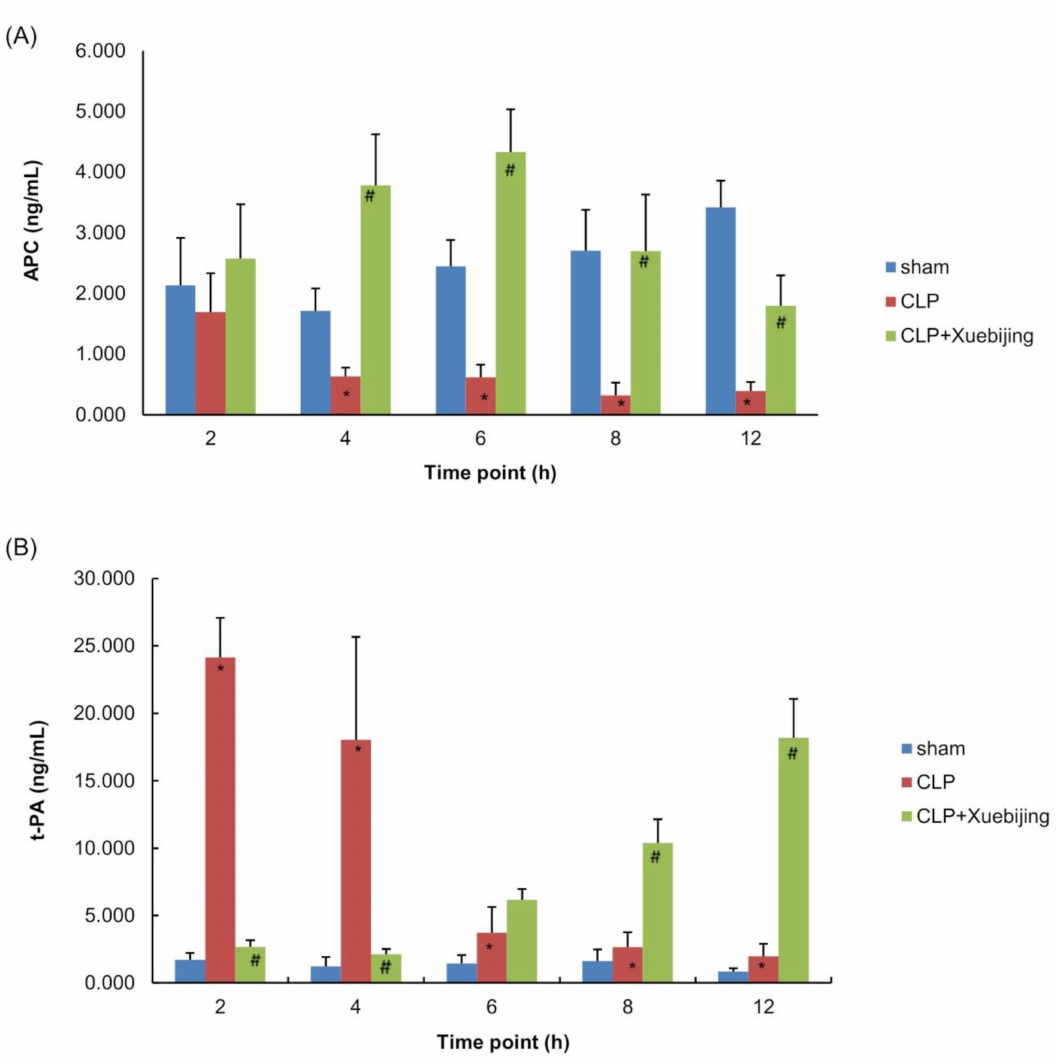
Figure 4. Xuebijing administration reversed CLP-induced alterations in circulating active protein C (APC) and tissue-type plasminogen activator (t-PA) levels in rats. Blood samples were collected at 2, 4, 6, 8, and 12 h after surgery from each subgroup. ELISA was performed to measure the plasma levels of APC ( A ) and t-PA ( B ) in rats. Data are expressed as the mean ± SD. * p < 0.05 vs. sham group, # p < 0.05 vs. CLP group; n = 5. CLP, cecal ligation and puncture; APC, active protein C; t-PA, tissue-type plasminogen